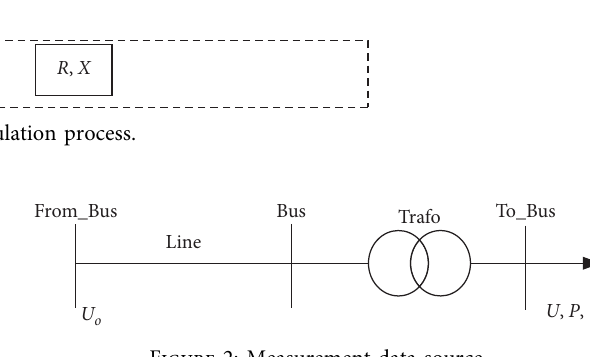
Figure 2: Measurement data